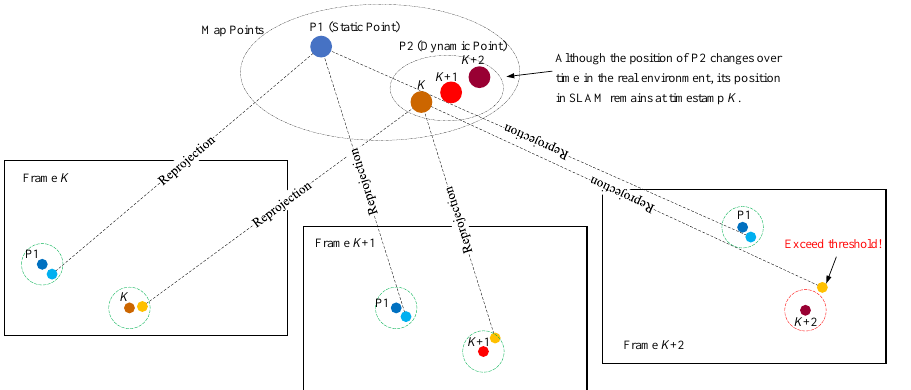
Figure 4. The difference between a static map point and a dynamic map point. For a static map point, the error between its reprojection and its feature point can always keep within a reasonable range.